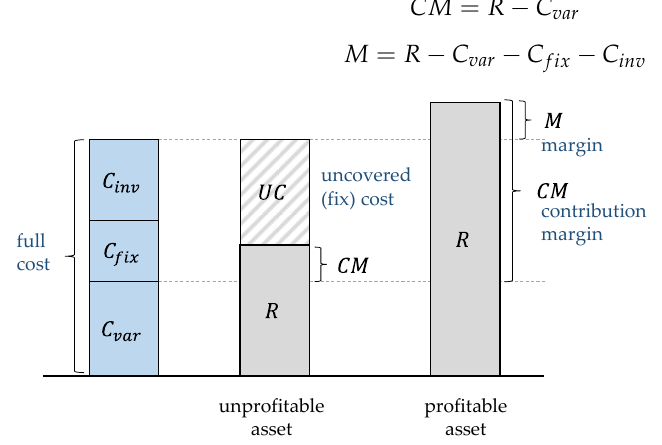
Figure 1. Definition of terms used for cost and margins in this paper.